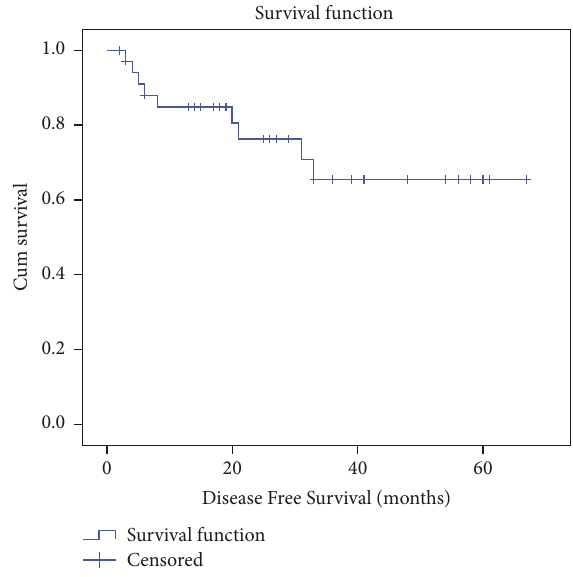
Figure 2: Kaplan-meier curve-disease-free survival for all